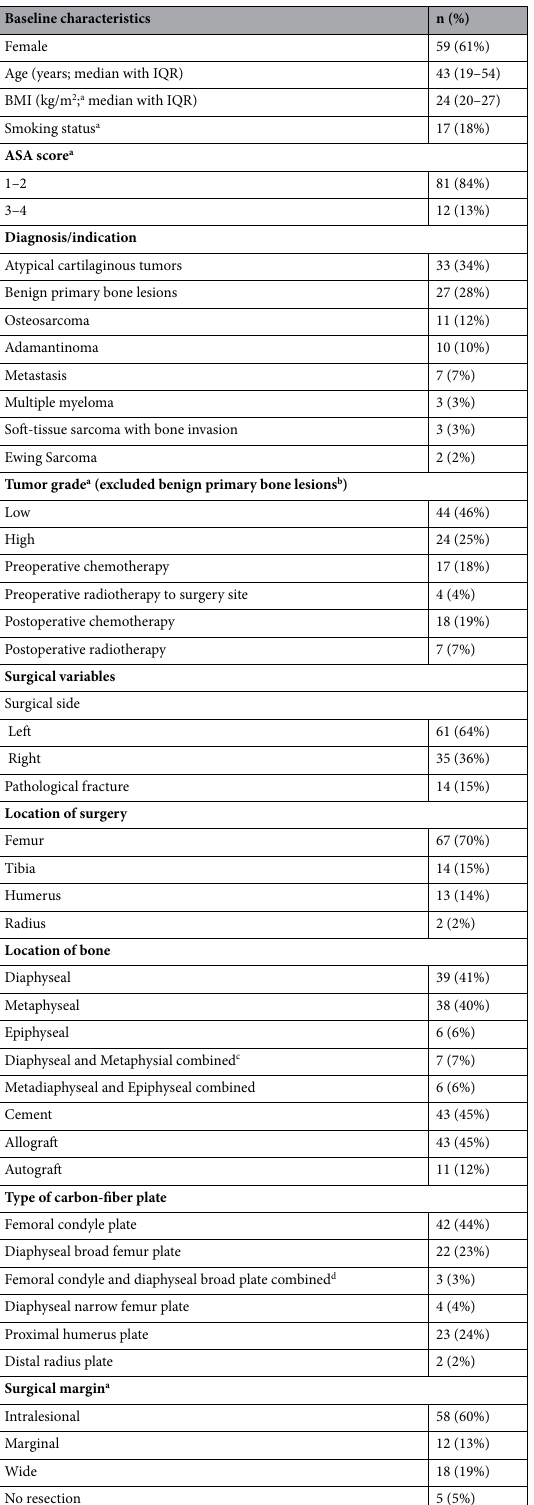
Table 1. Demographic features of included patients treated with carbon-fiber plates (n = 96). IQR = interquartile range, ASA = American society of anaesthesiologists, BMI = body mass index. a Missing data was present in BMI for 14/96